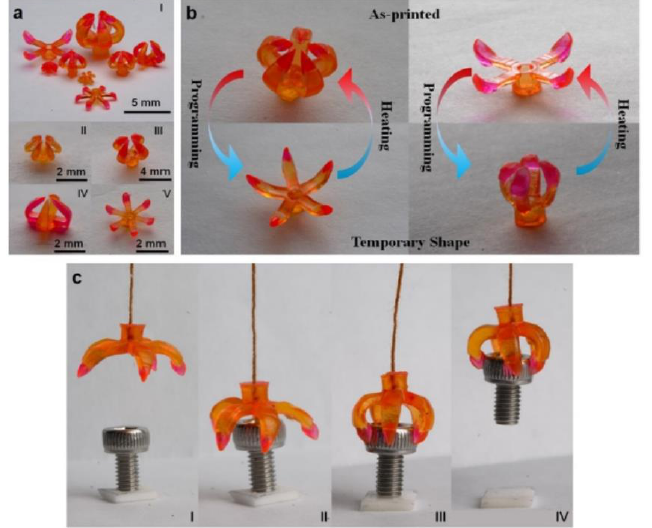
Figure 11. SLA-printed gripper with five arms. The gripper is small but with enough strain to hold a bolt [55]. ( a ) Multimaterial grippers are fabricated with different designs. ( b ) The explanation of the transition between as printed shape and temporary shape of multimaterial grippers. ( c ) The snapshots of the process of grabbing an object. Copyright © 2016, Scientific Reports.